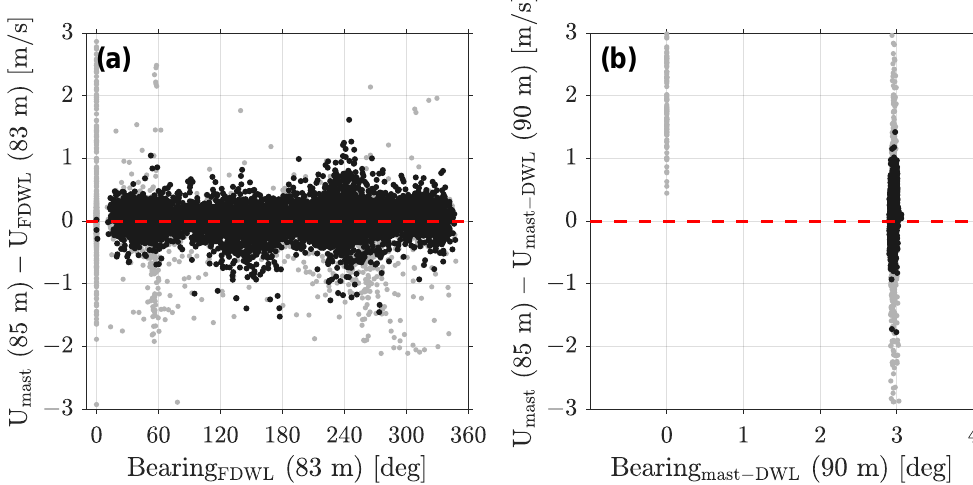
Figure 4. Lidar data screening: bearing. ( a ) HWS differences between the cup anemometer and the FDWL measurements as a function of FDWL bearing at a 83 m height. ( b ) Same as in panel ( a ) but compared to the fixed DWL on the mast. Black and grey dots indicate valid and outlier samples, respectively (Section 3.6). Dashed red line indicates the zero-bias